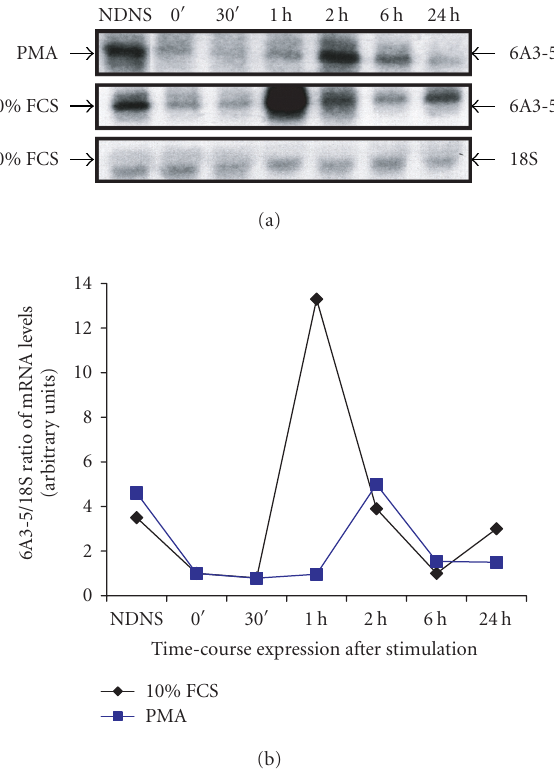
Figure 9. E ff ects of mitogenic agents on transcriptional expression of 6A3-5 and its possible implication in the proliferation of SMCs. (a) Synthetic SMCs (9th passage) were depleted from serum during 48 hours, then stimulated by mitogens such as 10% FCS or PMA (50ng/mL). Northern blots showed that 6A3-5 gene is downregulated in depleted SMCs (0 minute) in comparison to nondepleted and nonstimulated SMCs (NDNS). Moreover, the potent mitogen PMA induced a peak of 6A3-5 transcription levels after 2 hours of stimulation. However, northern blots showed that 10% FCS induced 6A3-5 gene transcription to a maximum after 1 hour of stimulation. The 18S served as a control for loading and quantification. (b) Quantification of 6A3-5 mRNA signals reported to the 18S levels. Results show that 6A3-5 gene expression is overexpressed by at least 400% (4-fold increase) in PMA-stimulated cells, 1–2 hours of stimulation. Stimulation with 10% FCS results in a 12-fold increase of 6A3-5 gene transcription 1 hour only after